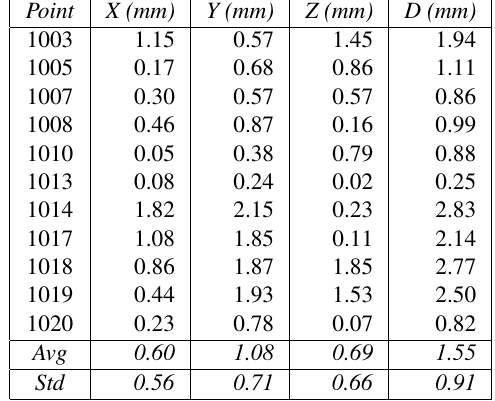
Table 1. Residual of CPs in detail of Case 1-Method 1.